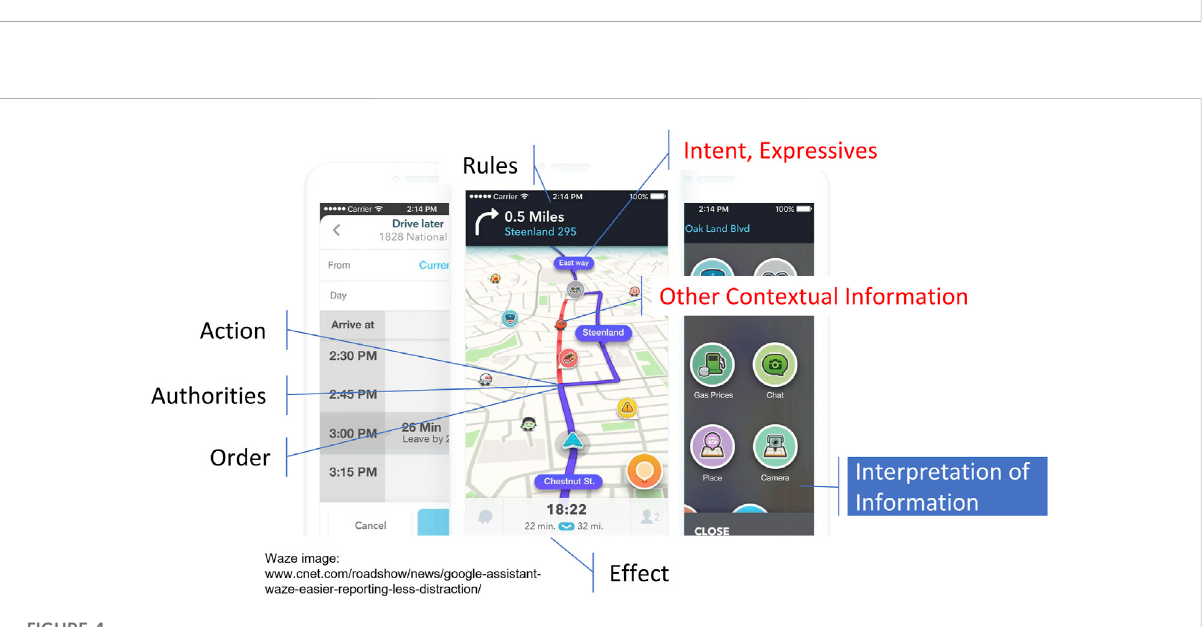
Generalized RECITAL control